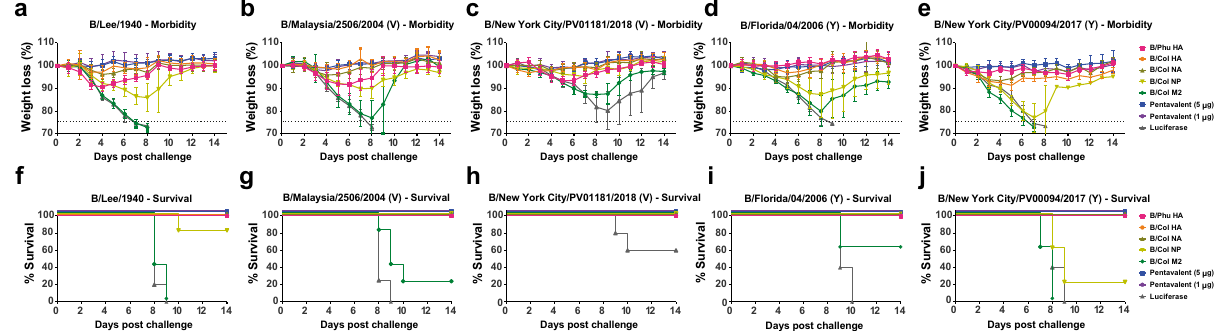
Fig.6|MorbidityandsurvivalgraphsformRNA-LNP-vaccinatedmicefollowing I.N. challenge with ancestral through recent IBV strains. Morbidity of mice vaccinatedwithasingledoseofmRNA-LNPscontainingmonovalentorpentavalent formulations following I.N. challenge with 5mLD 50 of B/Lee/1940 ( n =5) ( a ) B/ Malaysia/2506/2004 (V) ( n =5) ( b ), B/New York City/PV01181/2018 (V) ( n =5 for all groups except M2 where one mouse was found dead on day 1) ( c ), B/Florida/04/ 2006 (Y) ( n =5) ( d ), or B/New York City/PV00094/2017 (Y) ( n =4) ( e ) in fl uenza